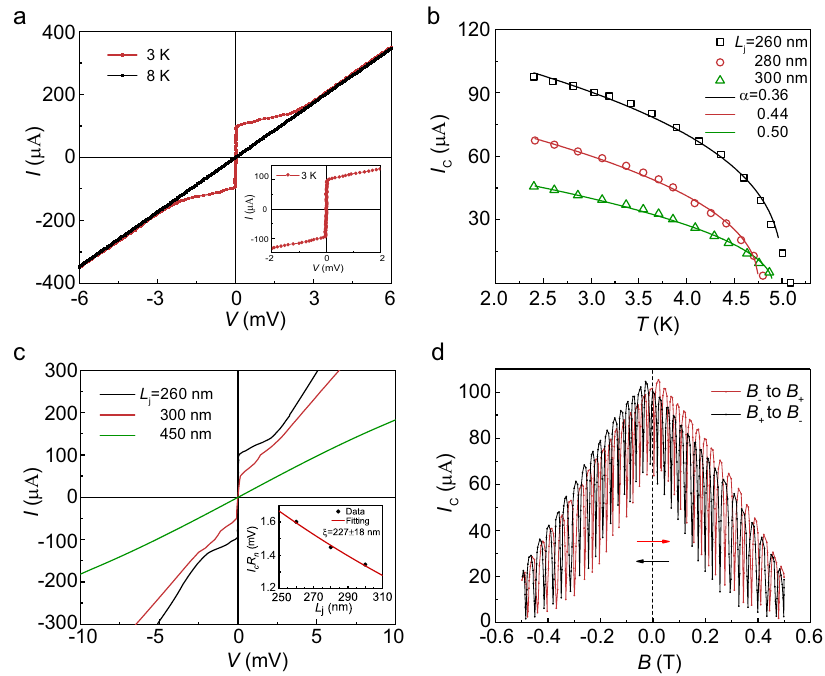
Fig. 2 | Transport characteristics of the S/F/S devices. a Current – voltage ( I – V ) curves for S/F/S Josephson junction at temperatures of 3 and 8K under zero magnetic fi eld, showing the I c ~100 μ A at 3K, and the inset shows the magni fi ed plot of I – V curve around zero voltage. b Critical current I c as a function of tem- perature with different L j of 260, 280, 300nm. The solid lines are theoretical fi tting curves. c Current – voltage ( I – V ) curves for Josephson junctions with